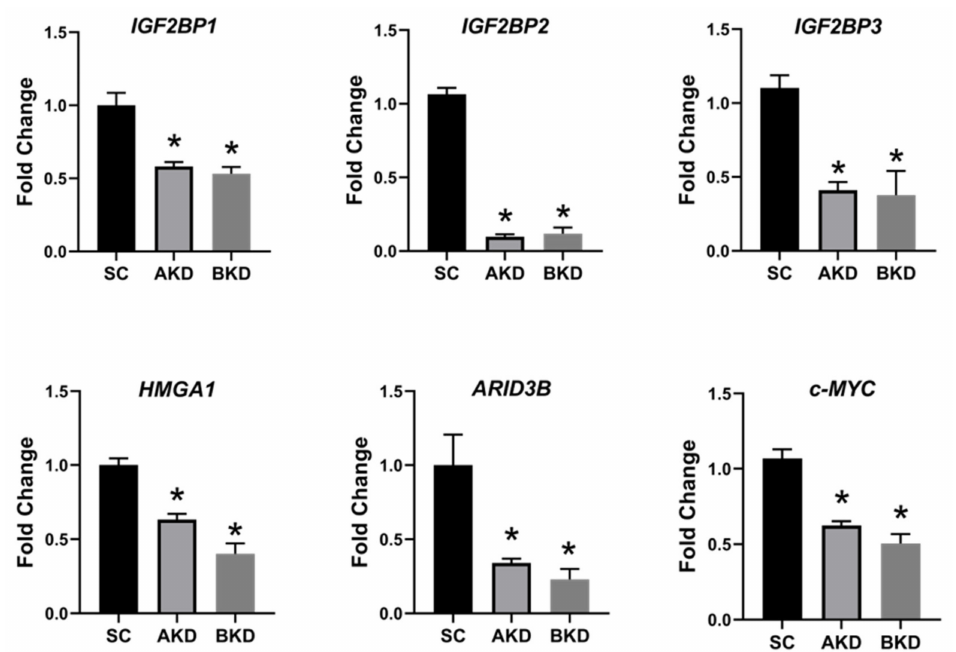
Figure 3. IGF2BP1, IGF2BP2, IGF2BP3, HMGA1, ARID3B, and c-MYC mRNA in AKD and BKD day 16 TE compared to SC ( n = 5), * p < 0.05 vs. SC.